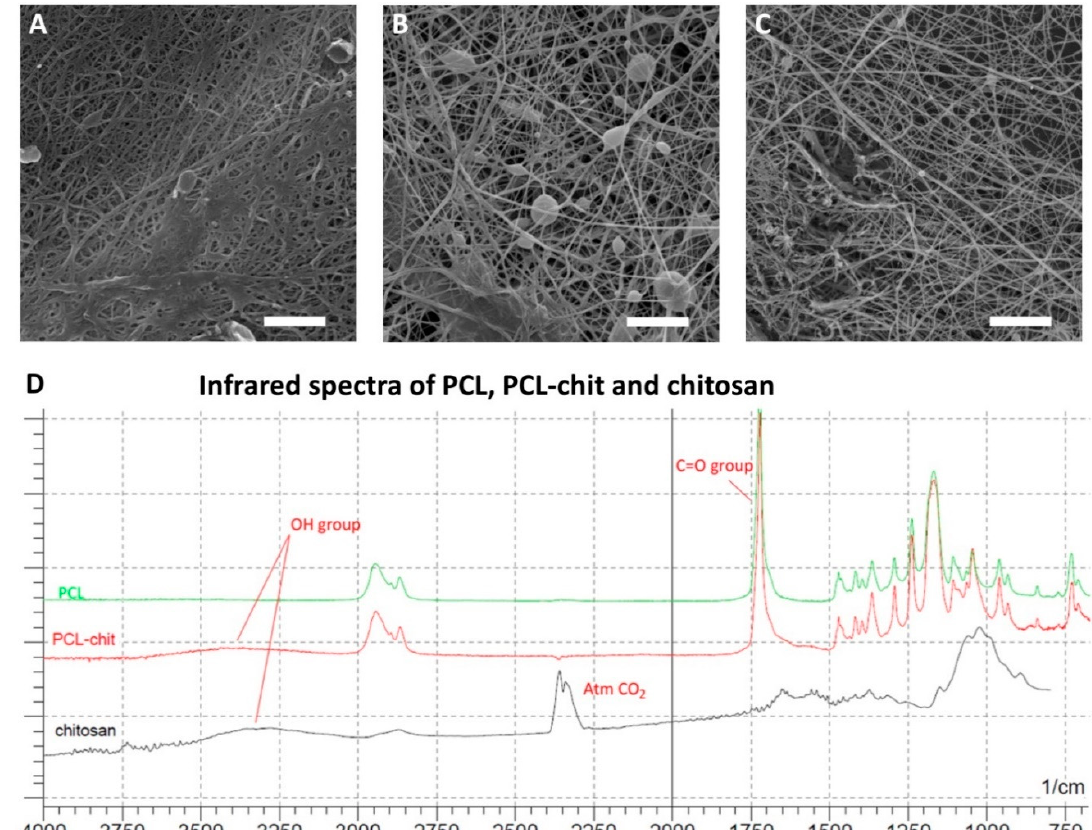
Figure 2. Morphology of nanofibers determined by SEM, poly- ε -caprolactone-chitosan (PCL-chit) ( A ), PCL-chit-PEGb ( B ) and poly(ethylene oxide)-chitosan (PEO-chit) ( C ). Characterization of PCL, PCL-chit and chitosan nanofibers by FTIR ( D ). Scale bar: 5 µm.